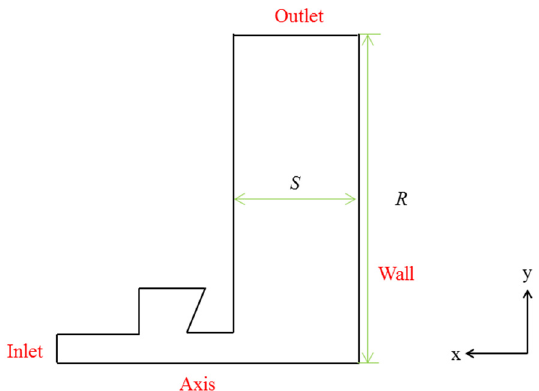
Figure 4. Schematic of computational domain.